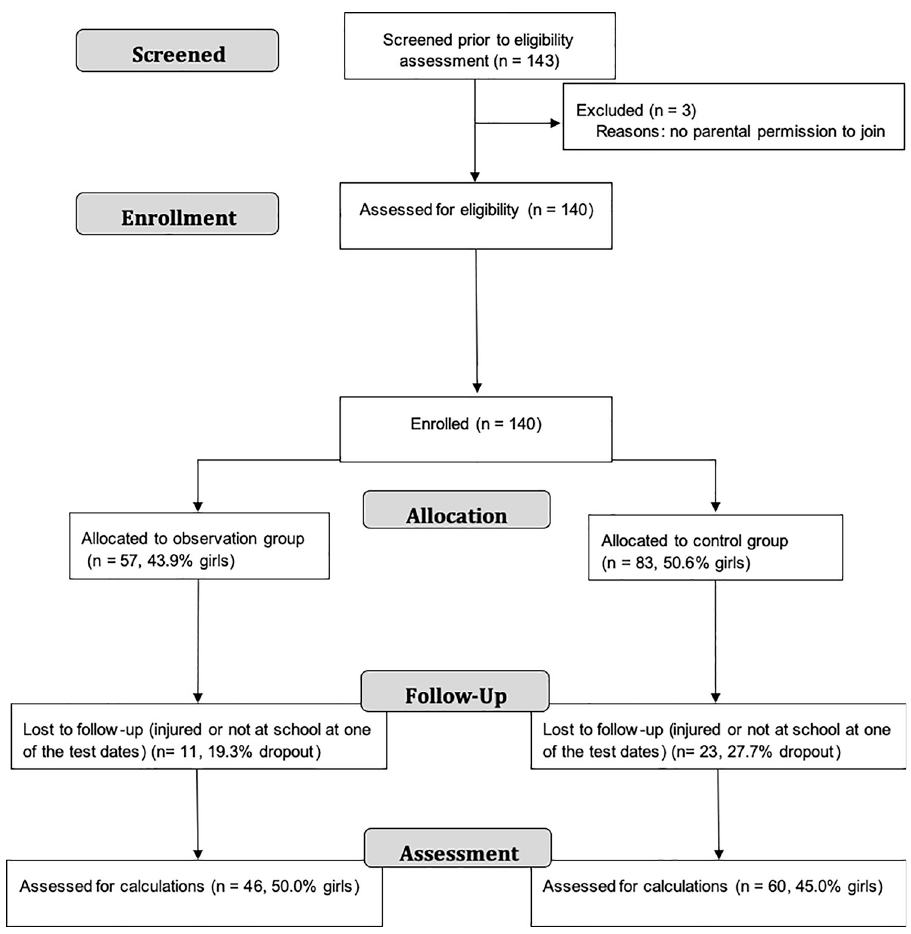
Fig 1. Participants. Consort flowchart demonstrating gender distribution and dropout